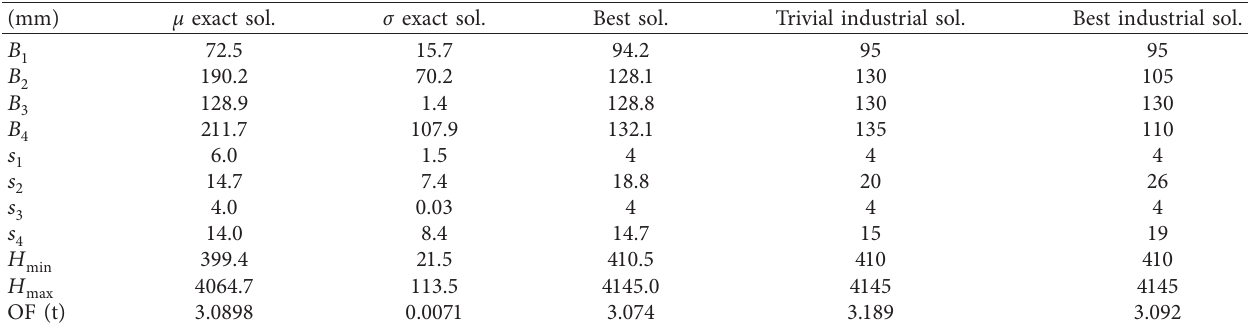
Table 5: Structural example 2: mean values μ and standard deviations σ of best results from 21 solution over 50 runs of PSO-SVM with OF less than 3.1t. Last three columns: best exact solution, trivial rounded-up solution, and refined industrial solution.